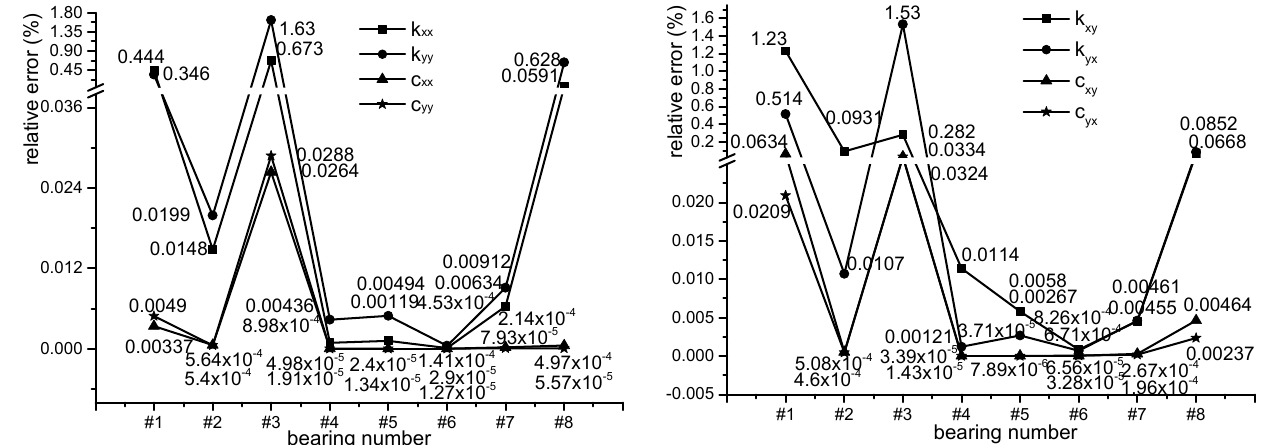
Figure 6. The biggest identification error obtained using h’4.4 based on Algorithm II. According to Figure 6, for the main coefficients, the maximum relative errors of k1.xx, k2.xx, . . . , k8.xx are almost equal to zero. They are only 0.444%, 0.0148%, 0.673%, 0.000898%, 0.00119%, 0.000141%, 0.00634% and 0.0591%, respectively. The maximum relative errors of c1.xx, c2.xx, . . . , c8.xx are smaller than those of the stiffness coefficients. They are